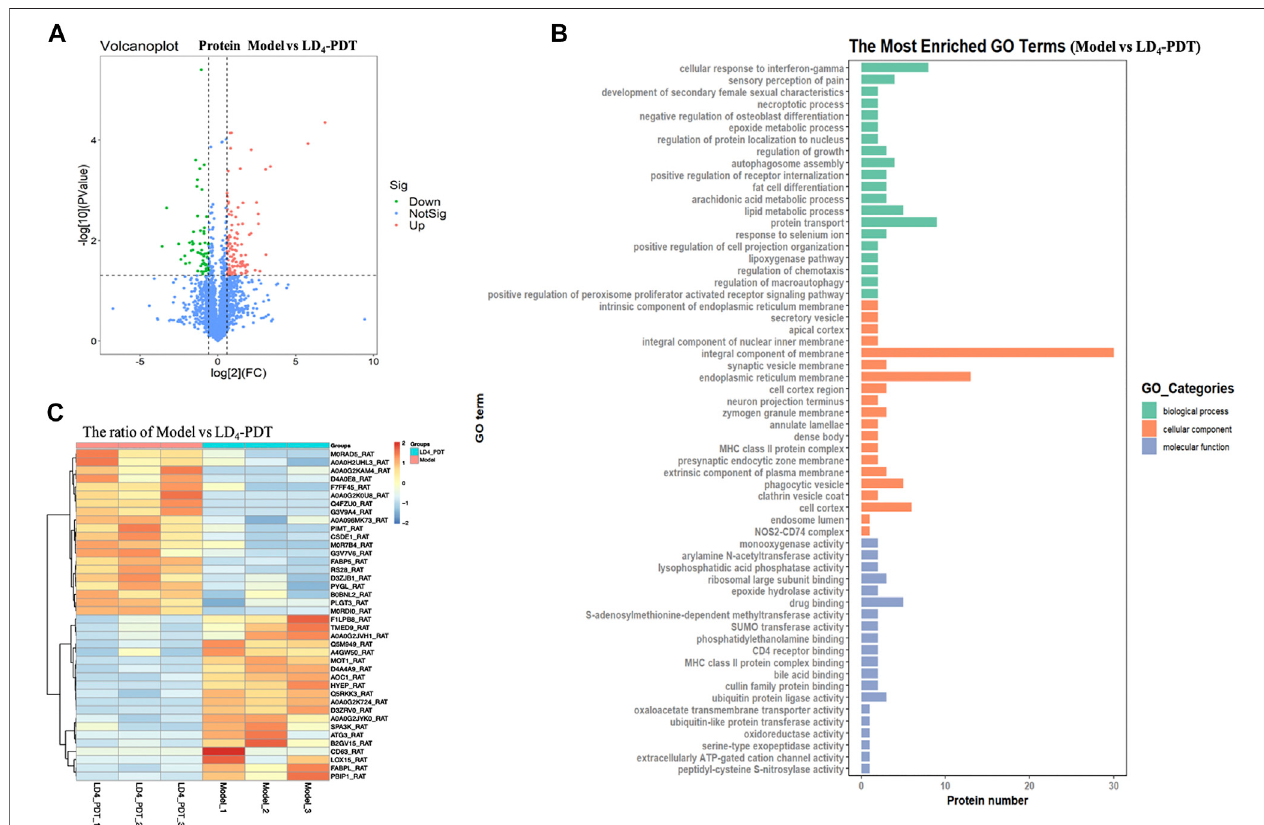
FIGURE 4 | LD 4 -PDT reprogrammed the protein pro fi le of colon tissues in TNBS-induced UC model rats. (A) Volcano plots showing the difference in protein expression among model and LD 4 -PDT groups. (B) All identi fi ed proteins were classi fi ed according to the fi rst 20 gene ontology ratios sorted by enrichment degree [ − log10 ( p-value )] and protein number according to biological process, cell composition and molecular function. Over-representation analysis was used for functional enrichment analysis, and the t-test based on hypergeometric distribution. (C) Heat map of 40 differentially expressed proteins among the model and LD 4 -PDT groups. Each column represented a sample, and each row represented a factor; red indicated elevated protein expression, green indicated decreased protein expression.